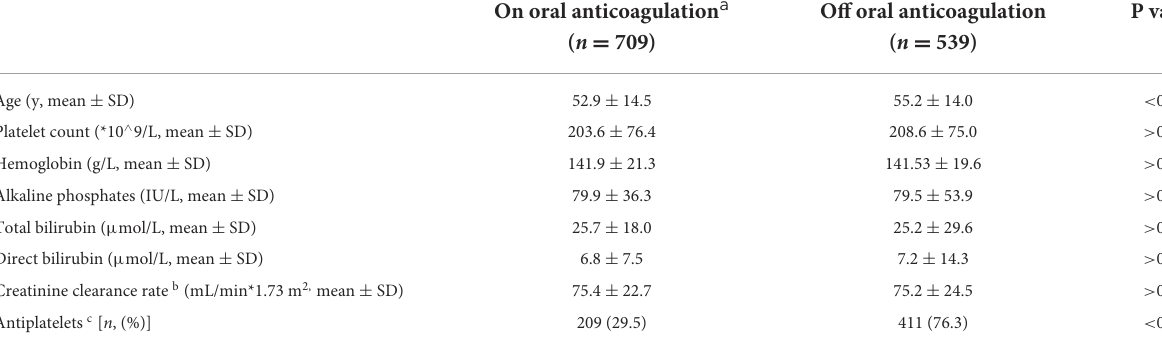
TABLE 3 Comparison between heart failure patients complicated with intracardiac thrombus on and off oral anticoagulation.